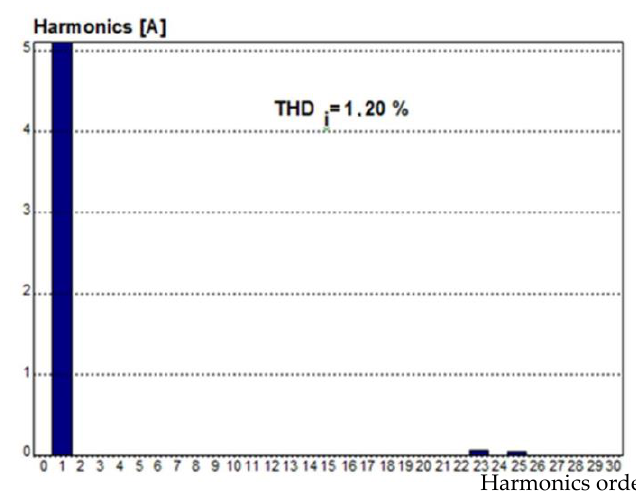
Figure 21. Spectrum analysis of the line currents at rated load.